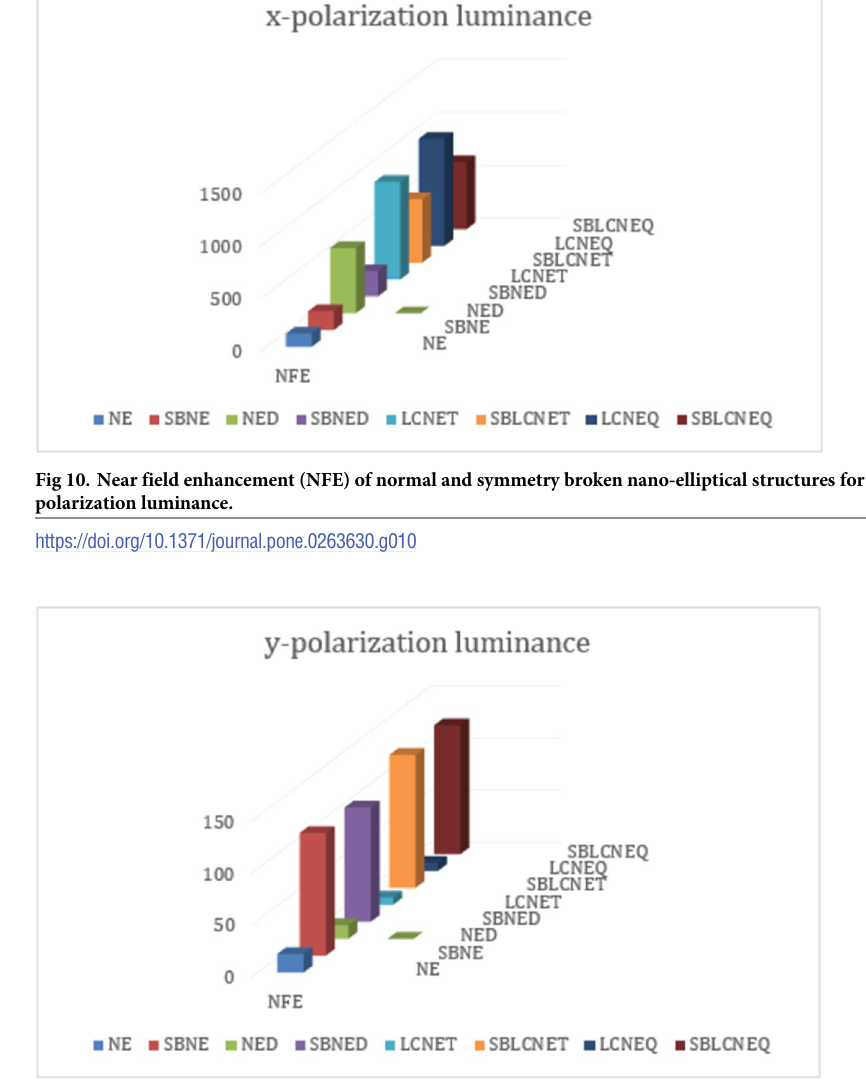
Fig 11. Near field enhancement (NFE) of normal and symmetry broken nanoelliptical structures for y- polarization luminance.